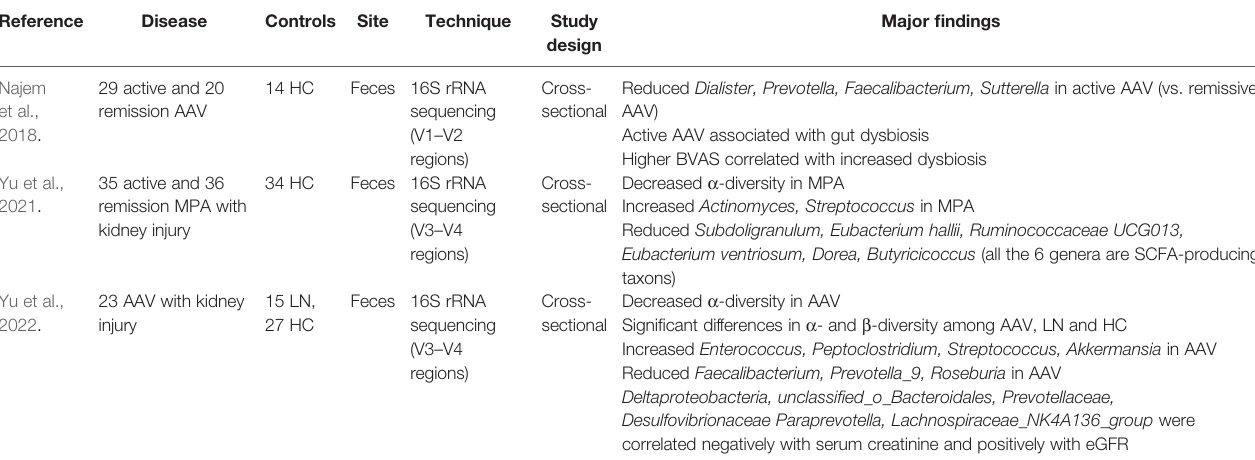
TABLE 2 | Summary of gut microbiome studies in